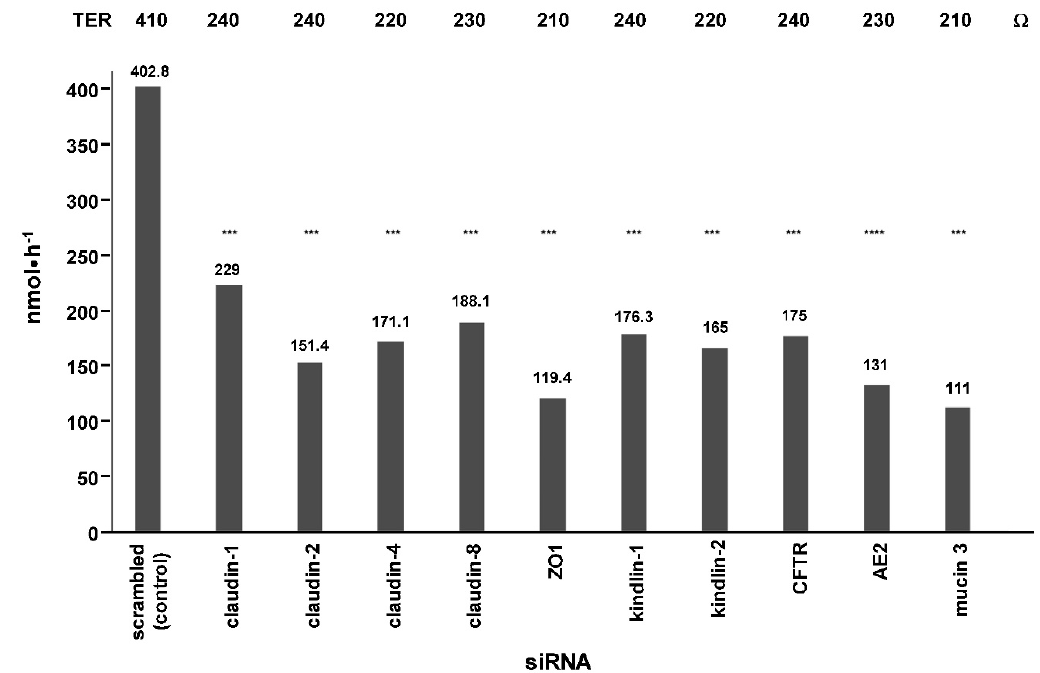
Figure 7. Effect of siRNA suppression of proteins involved in apical translocation of phosphatidylcholine (PC). Apical transport of PC after basal application of 10 mM PC: 10 mM taurocholate was examined after siRNA knockdown of indicated proteins which are all involved in tight junction-mediated luminal secretion of PC. Means ± SD of n = 6. Significances were calculated in relation to the control pretreated with scrambled siRNA; n.s. = not significant, *** p < 0.001. ZO1, Zonula Occludens-1; CFTR, cystic fibrosis transmembrane conductance regulator; AE2, anion exchange protein 2; TER, transepithelial resistance.